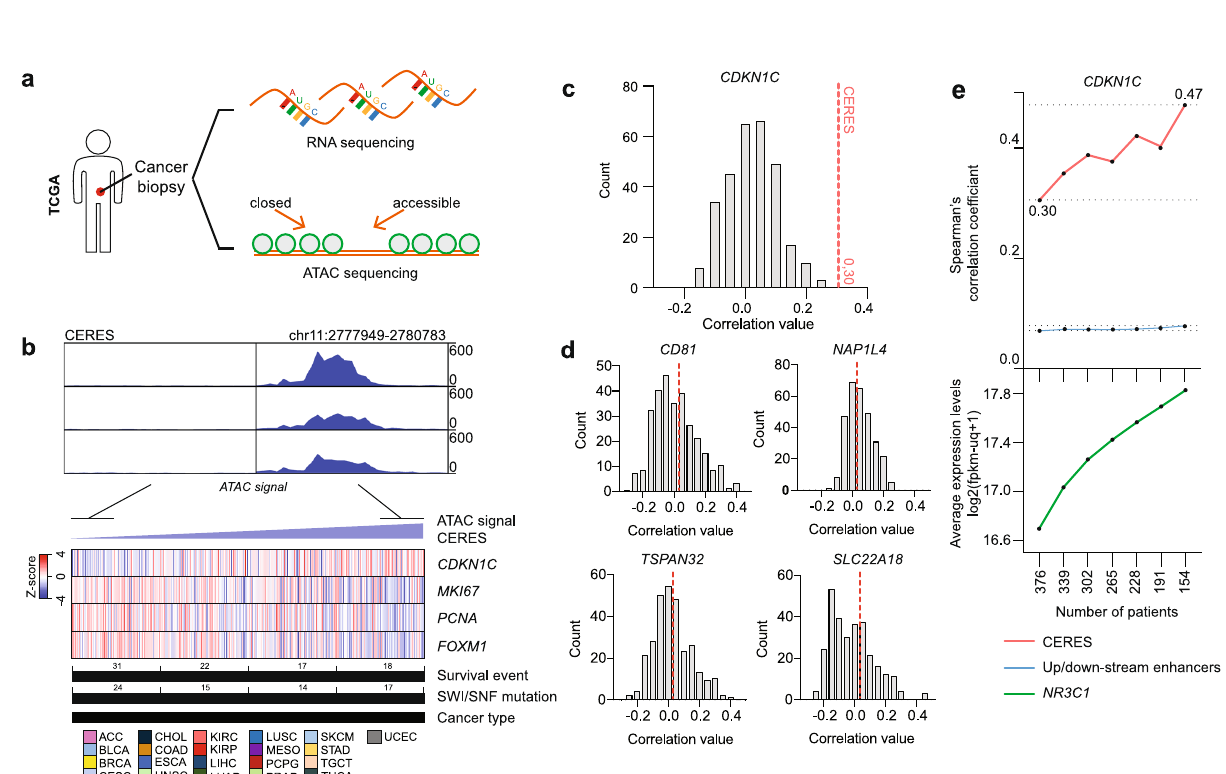
Fig. 5 SWI/SNF complex fi ne-tunes expression of CDKN1C . a Representative immuno fl uorescence images showing expression and localisation of GR (green), treated with glucocorticoids (GC) or control (Veh), using DAPI as nuclear staining (blue) ( n = 3). Scale bar, 10 μ m. b Heatmap of ChIP-sequencing signal around peak midpoint for all sites detected across the genome (top), and average signal of GR ChIP-seq experiments across all sites called over input control (bottom), for untreated (Veh) and glucocorticoid-treated (GC) cells. c Scatter plot depicting differential gene expression changes upon GC treatment in RNA sequencing. Genes signi fi cantly ( P adj ≤ 0.01) up- or downregulated by GCs are depicted in red ( n = 2). Adjusted P values were determined by DESeq2 (Wald test P values corrected for multiple testing using Benjamini and Hochberg method). d Scatter plot depicting enrichment over IgG control in a GR-RIME experiment. Proteins considered to be recruited by GR are 2.5 LFQ enriched over IgG (dotted line) and signi fi cant ( − log( P value ) >2; red) ( n = 3). P values were determined by two-sided t test. e Volcano plot depicting differentially enriched interactors in GR-RIME experiments between three cell lines with active and two cell lines with inactive GR ( n = 3). P values were determined by two-sided t test. f GSEA enrichment pro fi les for RNA polymerase II transcription factor complex (M17103; blue). Nuclear transcription factor complex (M17532; purple), SWI/SNF complex (M17713; red) and mediator complex (M17759; green) gene sets based on A549/H2122/H1944 and H1975/H460 comparison GR-RIME dataset ( n = 3). Nominal P values were determined by GSEA software. g Box plot depicting GR activity ( z score of 253 genes) in SWI/SNF WT ( n = 786) and mutant ( n = 91) human lung adenocarcinoma tumours. The central mark indicates the median, and the bottom and top edges of the box indicate the 25th and 75th percentiles, respectively. The notch displays a con fi dence interval around the median. The maximum whisker lengths are speci fi ed as 1.5 times the interquartile range and outliers are depicted as fi lled circles. P values were determined by Wilcoxon rank-sum test with continuity correction. h (left) Normalised mRNA expression level relative to shControl for SMARCD3 , ARID2 , SMARCD2 , SMARCC2 , SMARCB1 , SMARCA2 , SMARCE1 and ARID1A , in cell lines with shRNA targeting respective genes. Mean values with ± SEM depicted. ≥ 2 shRNAs per gene in biological duplicates ( n = 2). h (middle) Normalised (relative to untreated condition) CDKN1C mRNA expression level of GC-treated shSMARCD3, shARID2, shSMARCD2, shSMARCC2, shSMARCB1, shSMARCA2, shSMARCE1 and shARID1A H2122 cell lines. Mean values with ±SEM depicted. ≥ 2 shRNAs per gene in biological duplicates ( n = 2). h (right) Protein expression index (number of positive cells * average signal intensity) depicting quanti fi ed expression of p57 in immuno fl uorescence